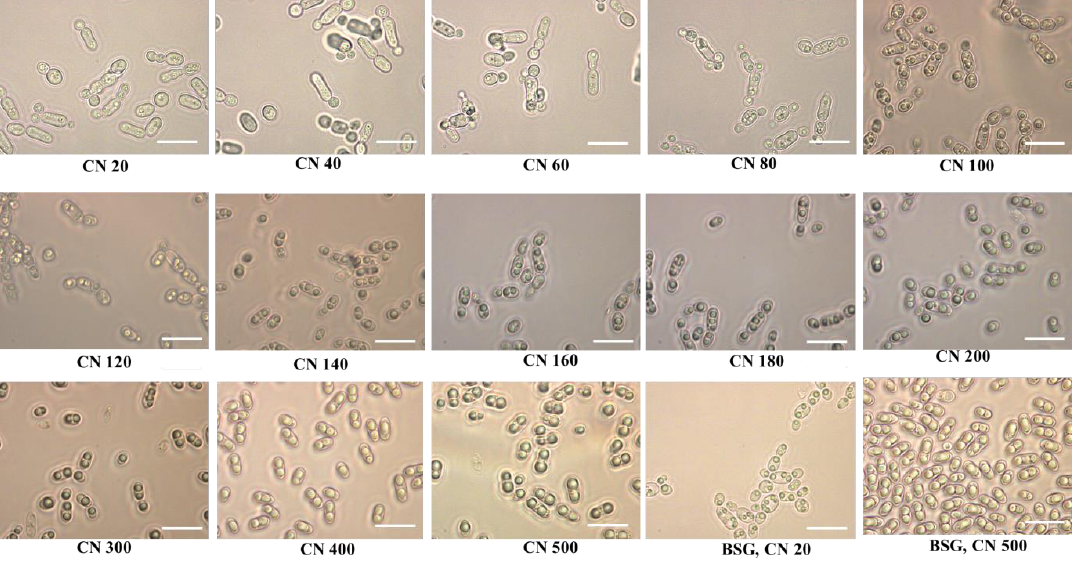
Figure 3. Representative images of cell morphology and lipid droplets synthesis in R. toruloides grown on a mixture of glucose (40 g/L) and xylose (20 g/L) at various C/N ratios and BSG hydrolysates (at C/N ratio of 20 and 500). The bar represents 10 μ m.